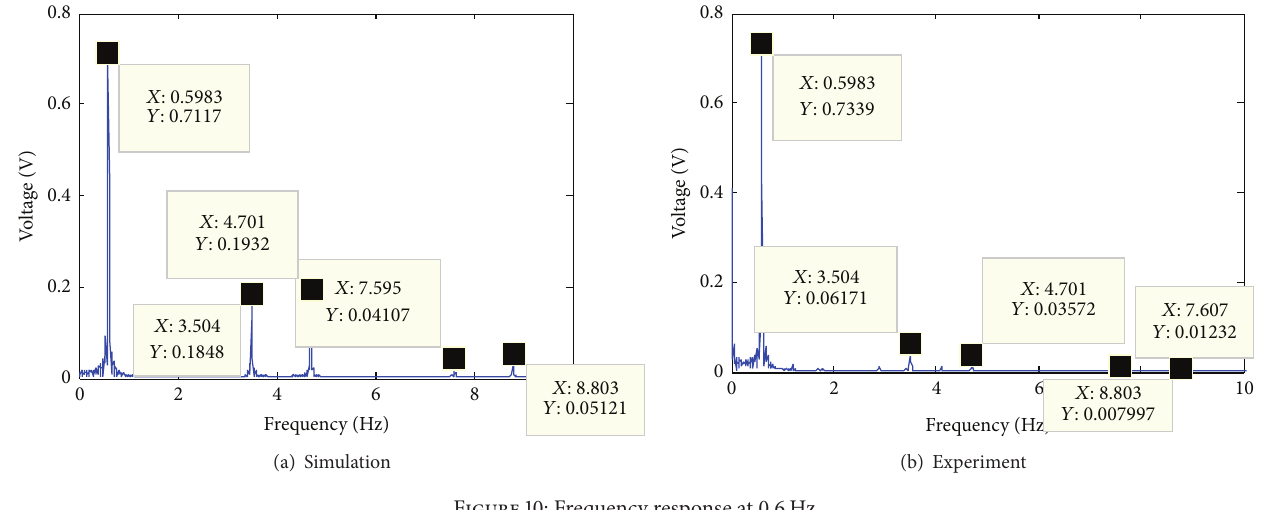
Figure 10: Frequency response at 0.6 Hz.